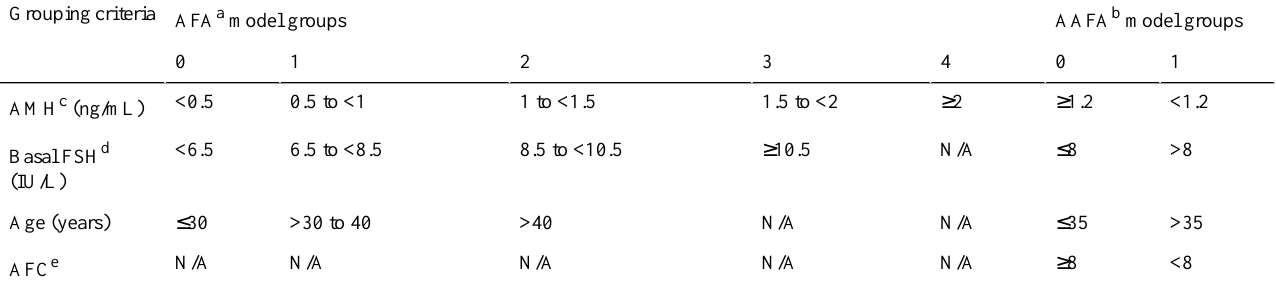
Table 2. Comparison of grouping criteria of the AFA and AAFA